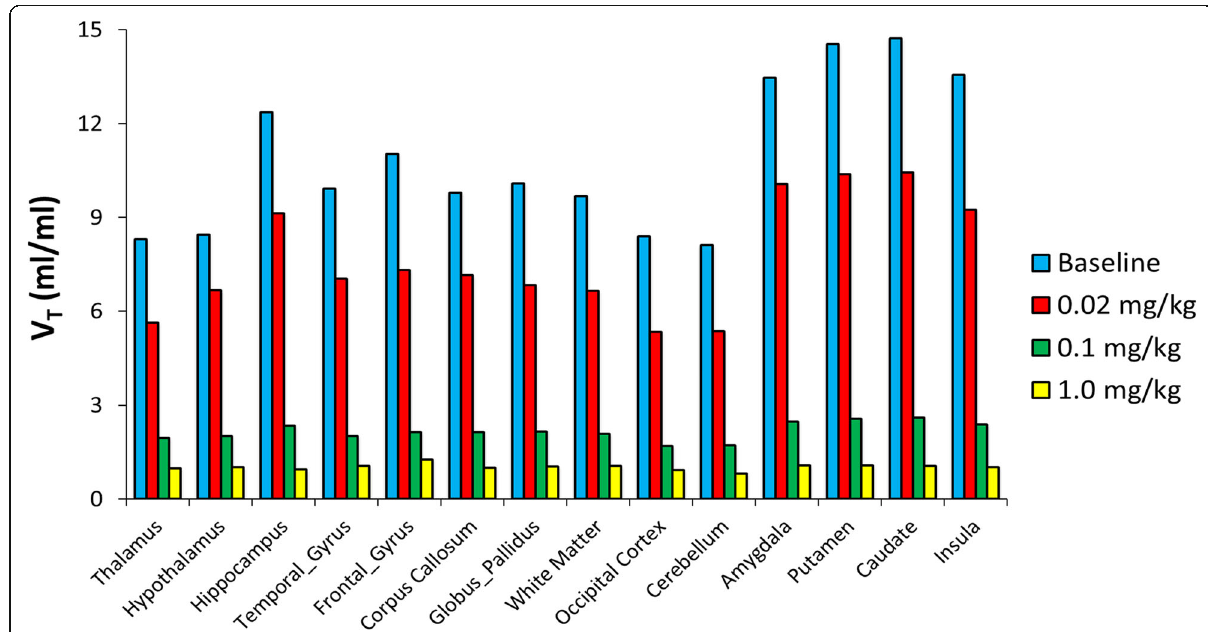
Fig. 5 The regional V T from baseline scan and three blocking scans with AR-9281 estimated from the Logon graphic method for